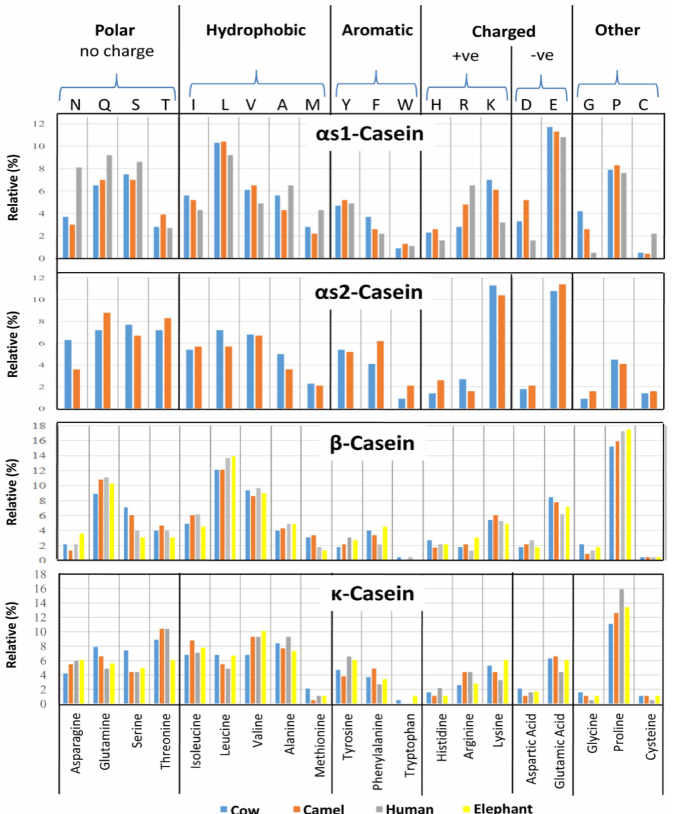
Figure 3. The percentage distribution of the amino acid residues of α S1-, α S2-, β -, and κ -caseins of the milks of cow, camel, human, and elephant.